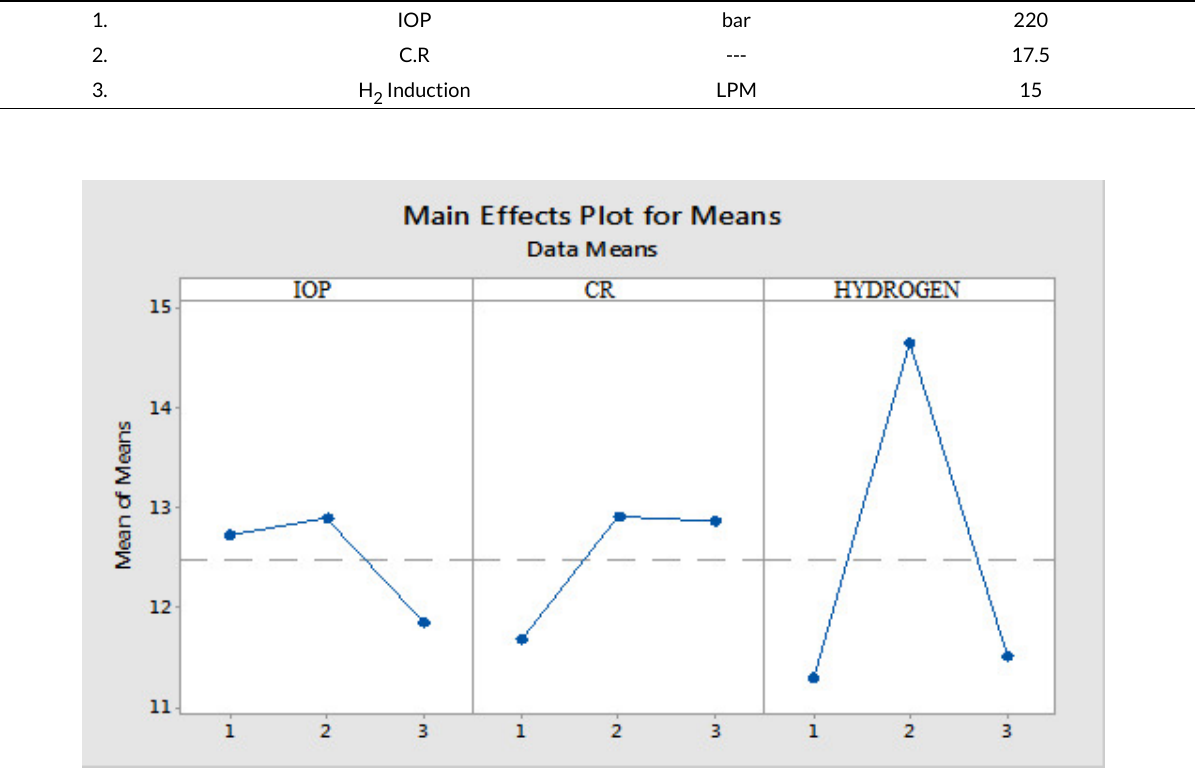
Figure 4. ANOM Plot for IOP, CR and Hydrogen.